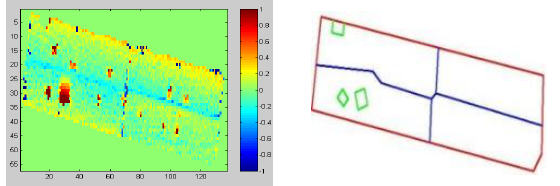
Figure 7. Color coded error map (left) for a 2D roof model (right) of a simple building (Hermanni site)